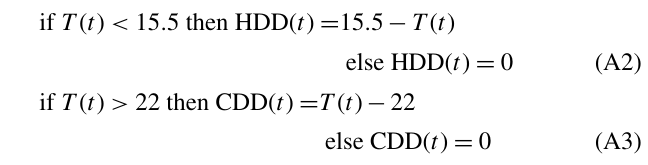
Figure A2. Wind power curves used in wind power